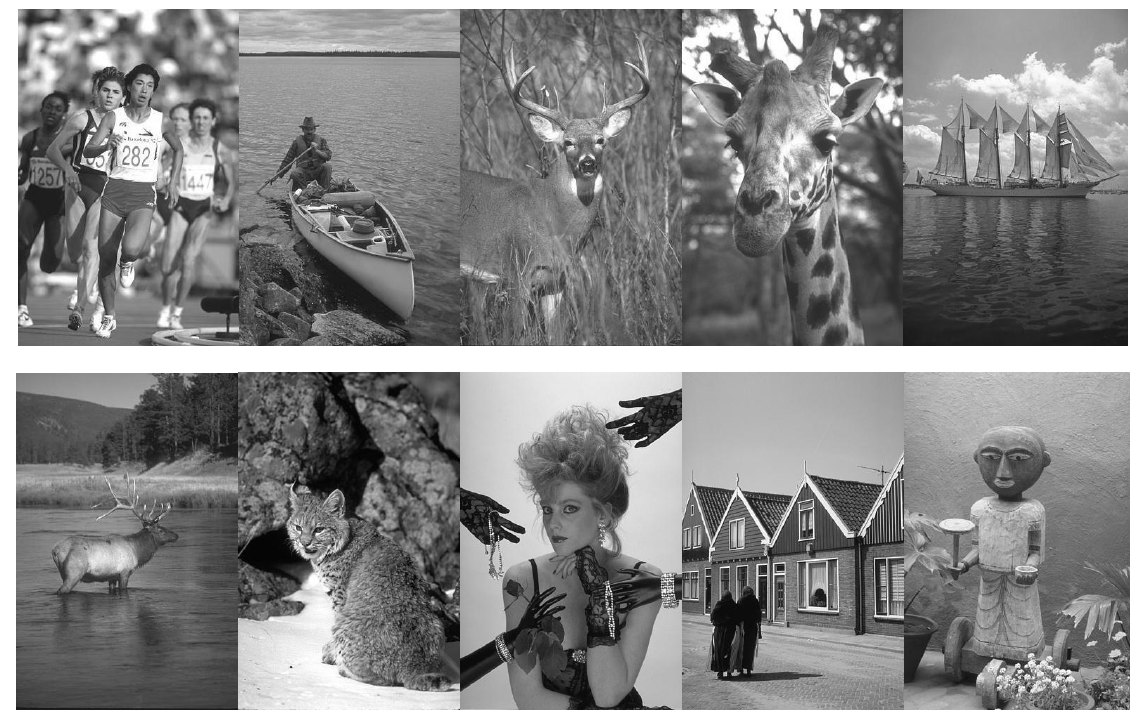
Figure 8. Some representative images in the BSD database.